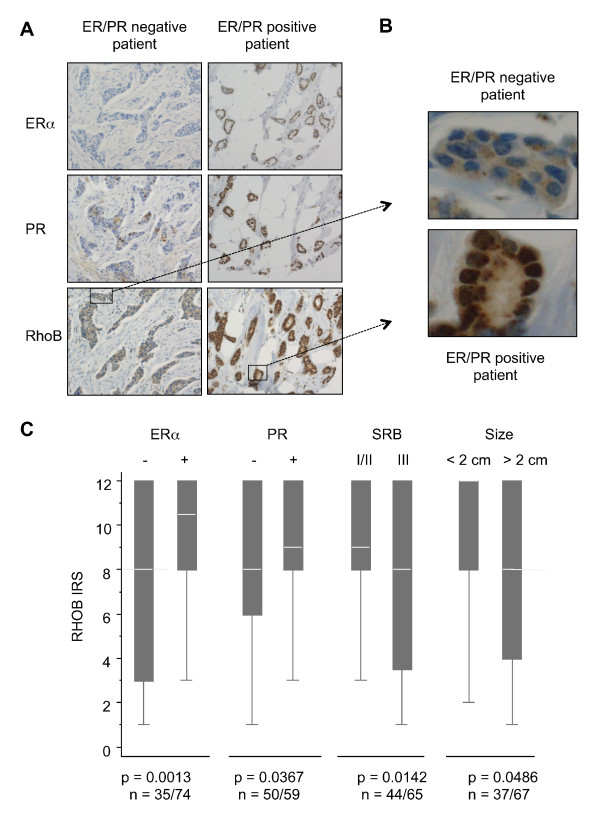
RhoB, estrogen receptor alpha and progesterone receptor expression in tumor samples of breast cancer patients. (A) Immunohistochemistry staining shown for two patients, representative of both the estrogen receptor (ER)/progesterone receptor (PR)-negative and ER/PR-positive populations (×200). (B) Enlargement of the squares represented in (A) (RhoB staining). (C) Medians of RhoB ImmunoReactive Score (IRS) scores according to ERα and PR positivity, tumor histological grade and tumor size.